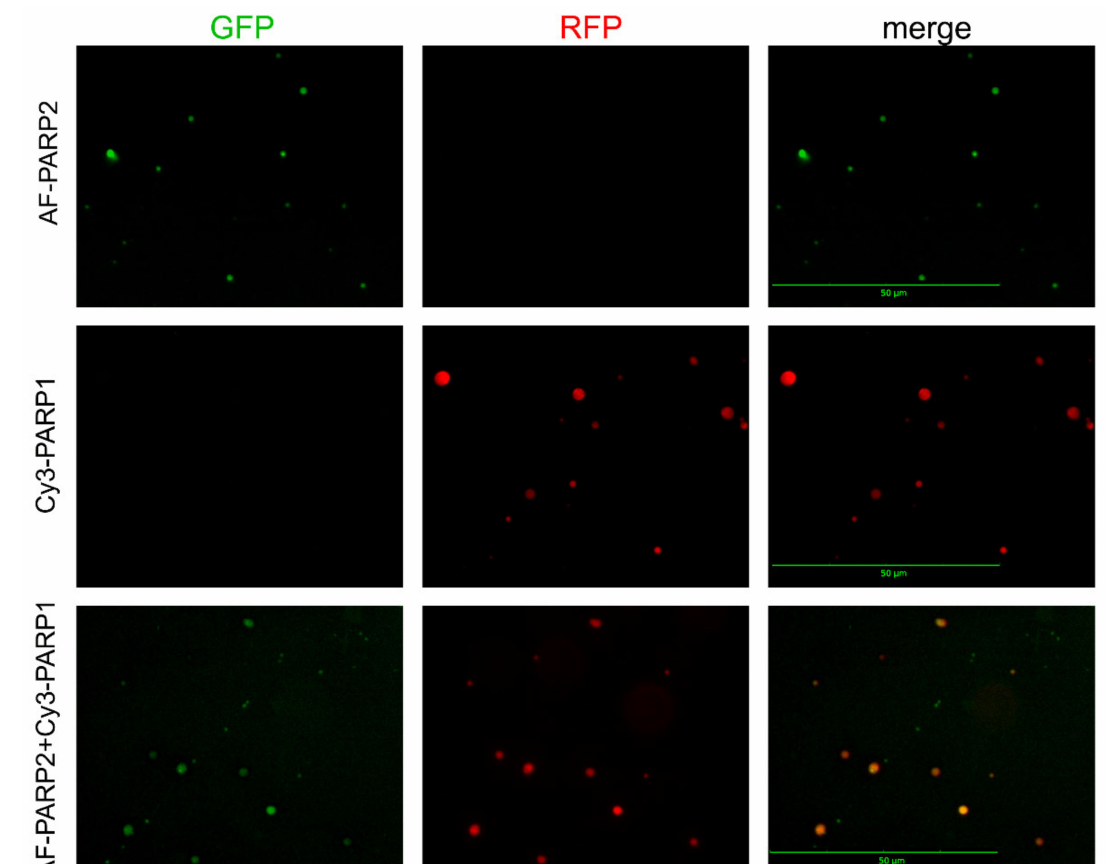
Figure 4. Fluorescence detection by the Celena S Digital Imaging System of protein associates formed upon PARylation reaction catalysed by PARP1, PARP2, and their equimolar mixture. The proteins labelled with distinct fluorophores (AF-PARP2, Cy3-PARP1) were visualized in images acquired with appropriate filters (GFP for AF and RFP for Cy3); the overlapped signals for distinct fluorophores were visualized in the superimposed image (merge). Scale bar, 50 µ M. Preparation of samples is detailed in Materials and